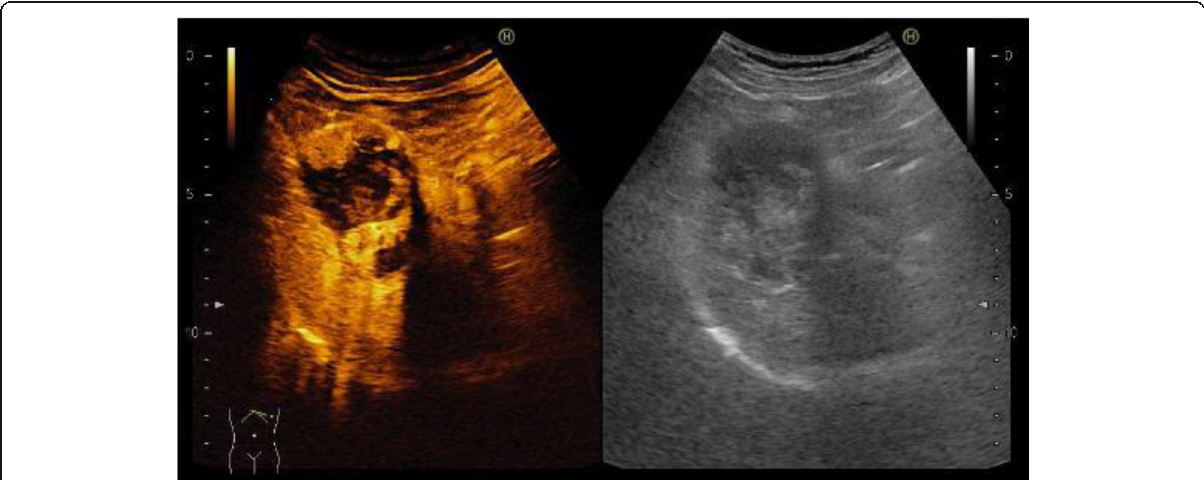
Fig. 1 Abdominal ultrasonography findings. A 51-mm-wide tumor in hepatic segment 4 with heterogeneous echo was detected and it didn't present bloodstream increase. Sonazoid enhanced ultrasonography with hypervolemic contrasting pattern revealed that the tumor was enhanced in the early phase and washed out in the late phase